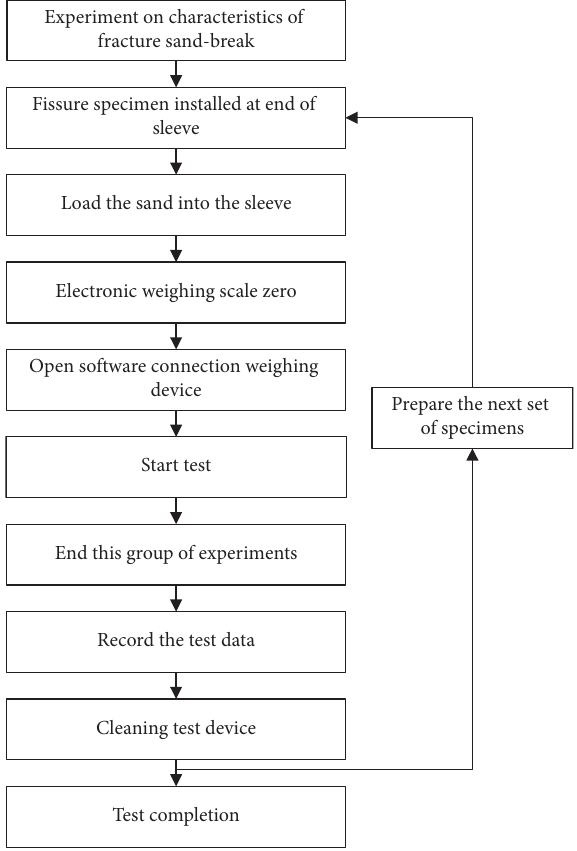
Figure 6: Flow process diagram of fracture sand